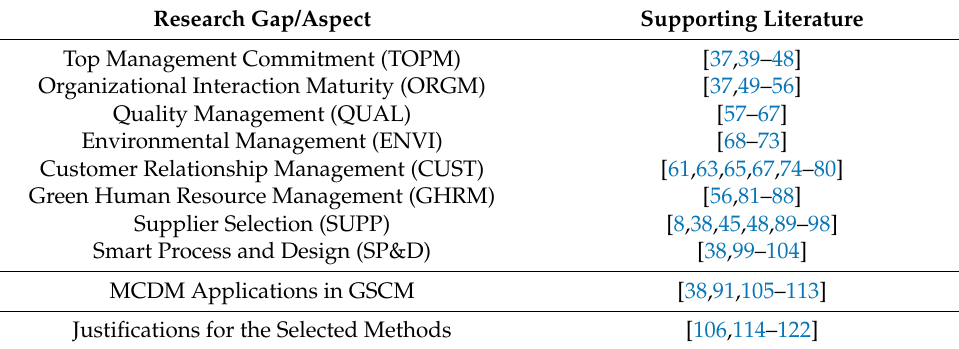
Table 2. Summarization of the supporting